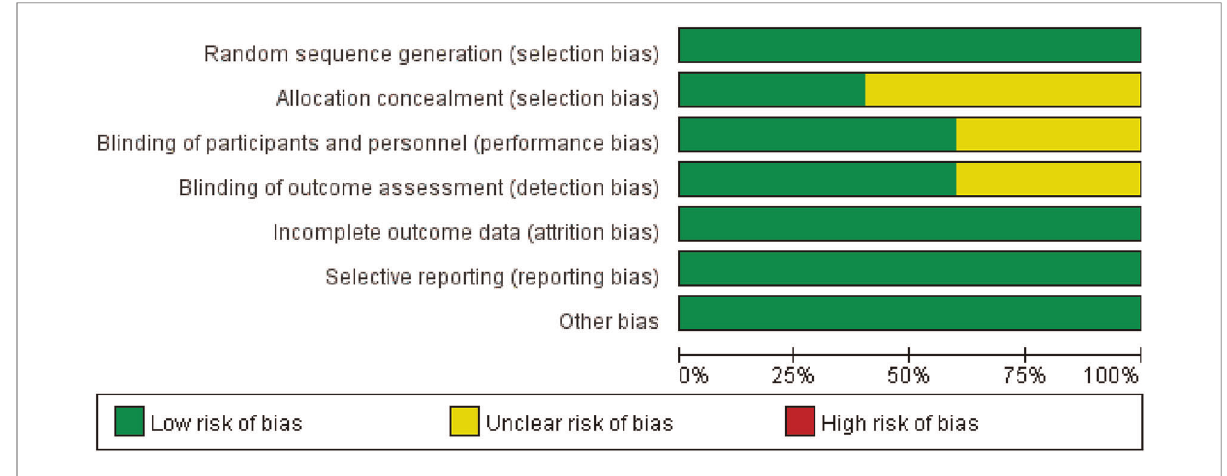
FIGURE 2 Risk of bias in included